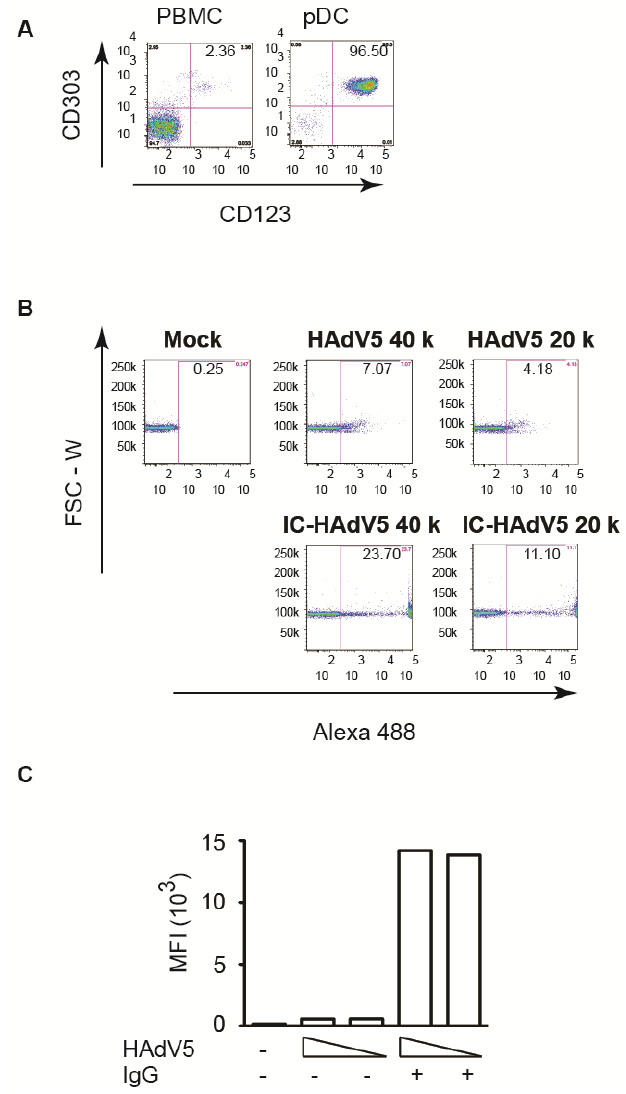
Figure 1. pDC purity and infection by HAdV5 and IC-HAdV5. ( A ) pDCs were isolated from PBMC by negative selection kit. pDCs and PBMCs were stained CD123 and CD303 to check pDC purity. ( B , C ) pDCs were challenged with IgG, HAdV5-Alexa488, or IC-HAdV5-Alexa488 at 20,000 and 40,000 pp/cell) (an example from a single donor). ( C ) Cumulative data from 3 donors. Median fluorescent intensity